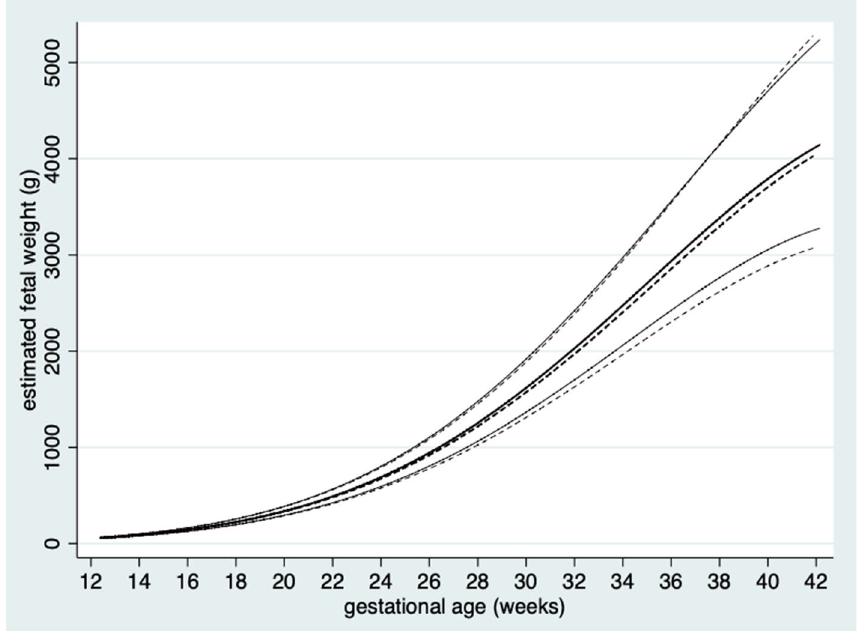
Figure 4. Sex specific reference ranges for estimated fetal weight by gestational age at 2.5th, 50th and 97.5th percentiles for male fetuses (continuous) and female fetuses (dashed).